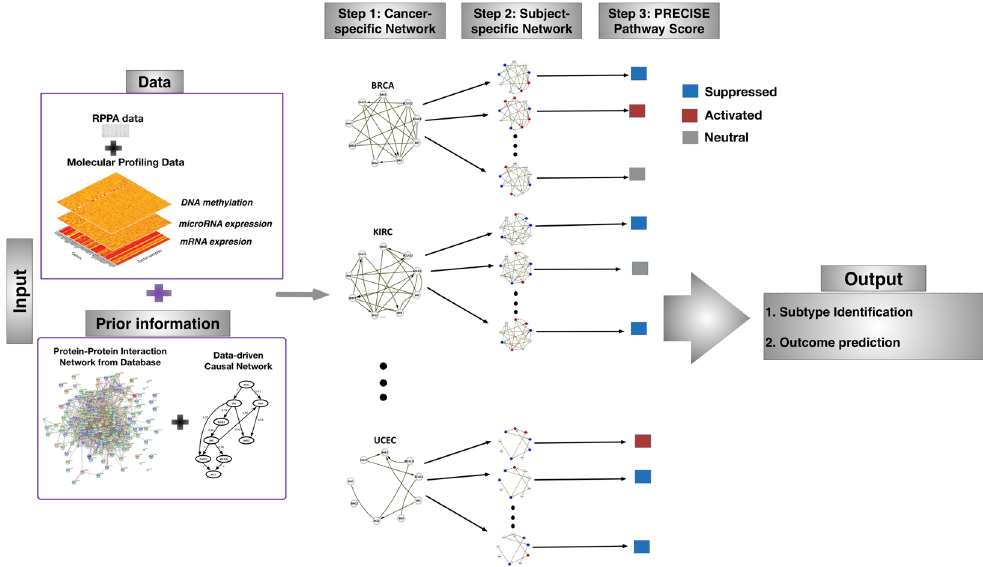
Figure 1. Overview of the Personalized Cancer-specific Integrated Network Estimation (PRECISE) method. PRECISE combines information from multiple platform molecular data and prior existing information from known protein-protein interaction databases. In Step 1, cancer-specific integrated protein networks are estimated by Bayesian regression models for each of signaling pathways using the prior networks and upstream molecular profiling data. In Step 2, PRECISE (subject-specific) networks are constructed by deconvolving proteomic network activity for each patient. In Step 3, PRECISE pathway scores are calibrated by summarizing each of the PRECISE networks for each pathway using the network topological